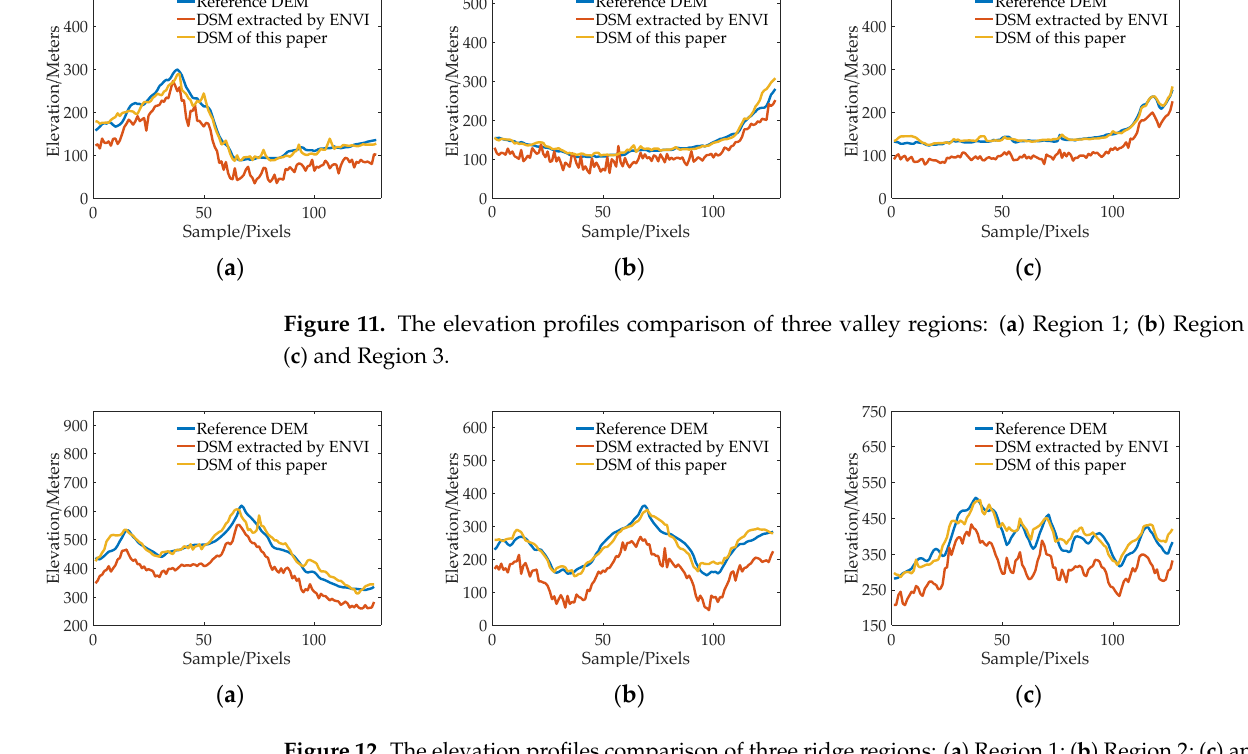
Figure 10. DSM of the urban region: ( a ) Reference DEM of urban region 1; ( b ) DSM extracted by ENVI of urban region 1; and ( c ) DSM of this paper of urban region 1.